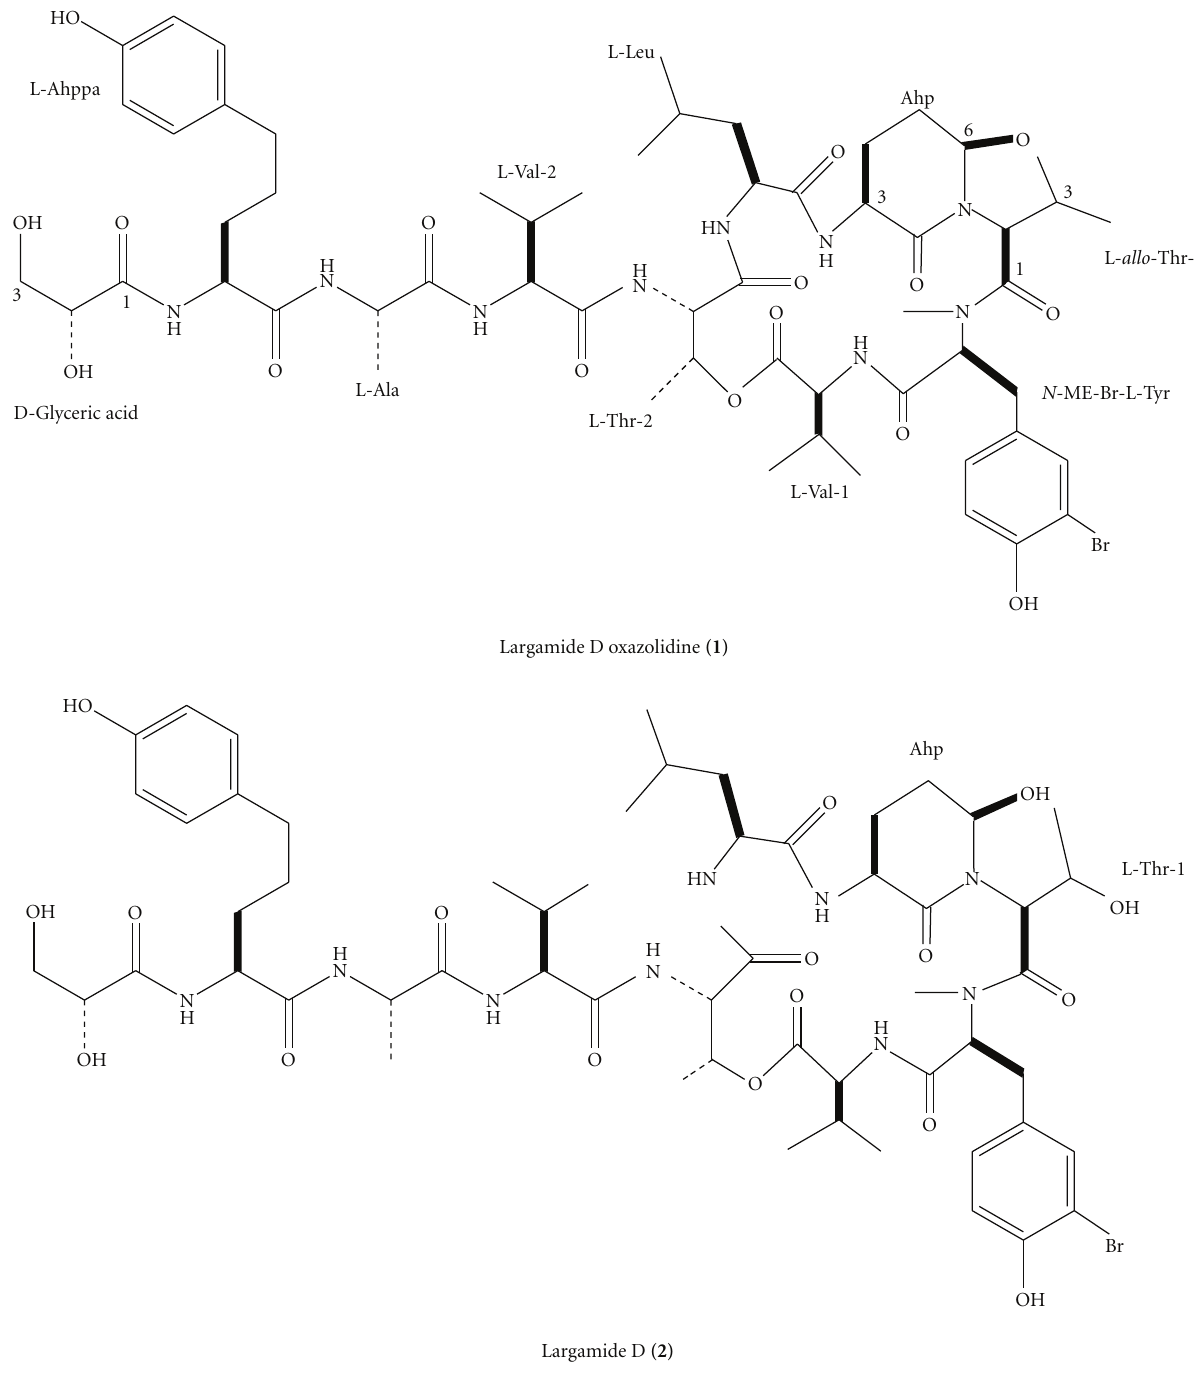
Figure 11: Structures of largamide D oxazolidihe (1) , largamide D (2)